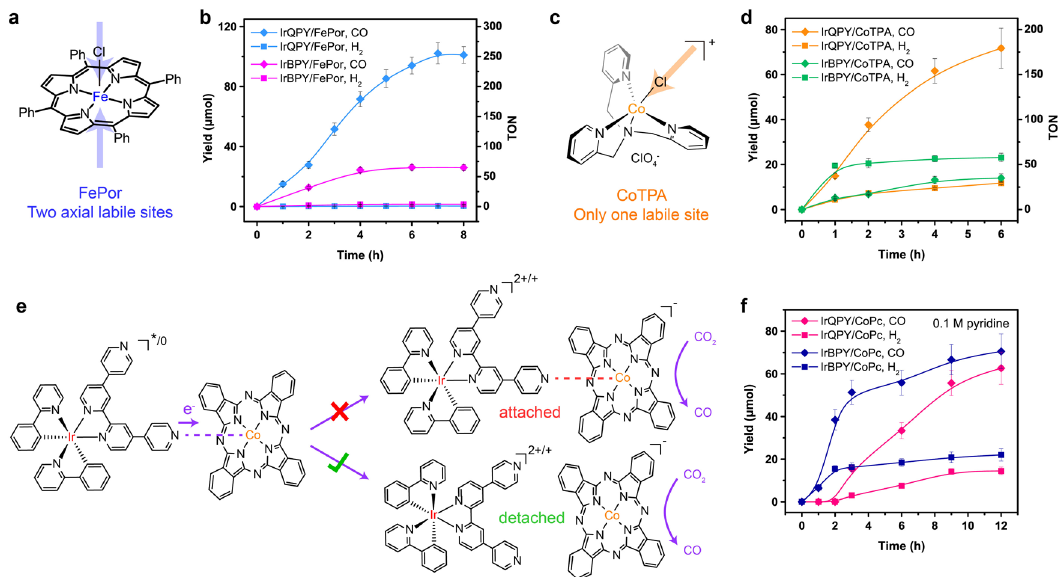
Fig. 5 Wide applicability of dynamic coordination interaction. a Structure of FePor. b Time pro fi les of photocatalytic CO (diamond) and H 2 (square) formation from a mixture of FePor (0.1 mM), IrQPY (blue, 0.1 mM) or IrBPY (magenta, 0.1 mM), TEA (2.5 v%) and BIH (80 mM). c Structure of CoTPA. d Time pro fi les of photocatalytic CO (diamond) and H 2 (square) formation from a mixture of CoTPA (0.1 mM), IrQPY (orange, 0.1 mM) or IrBPY (green, 0.1 mM), PhOH (5.0 v%), TEA (2.5 v%) and BIH (80 mM). e Proposed reaction mechanism for the relative states of IrQPY and CoPc during electron transfer and CO 2 reduction. f Time pro fi les of photocatalytic CO (diamond) and H 2 (square) formation from a mixture of pyridine (0.1 M), CoPc (0.1 mM), IrQPY (pink, 0.1 mM) or IrBPY (navy, 0.1 mM), TEA (2.5 v%), PhOH (6.0 v%) and BIH (80 mM). The error bars in the plots represent the standard deviations of three independent